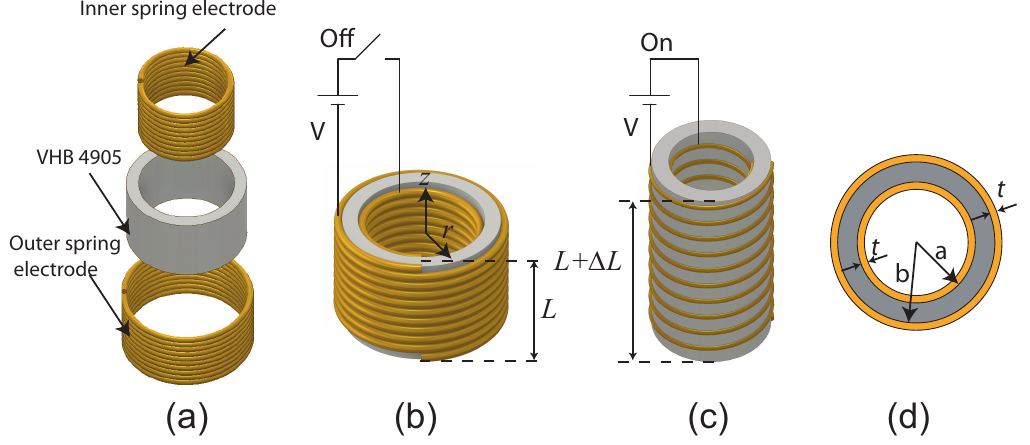
Figure 2. ( a ) Exploded view of proposed cylindrical Dielectric Elastomer Actuators (DEA) comprising VHB 4905 (3M Company, Maplewood, MN, USA) thin film folded into a hollow tube and sandwiched between two copper springs (inside and outside), which act as compliant electrodes; ( b ) without external electrical stimuli, device maintains its original shape; ( c ) under external electrical stimuli, device extends in the axial direction and decreases in the radial direction; ( d ) top view, where a is inner radius of VHB tube, b is outer radius of VHB tube, and t is wire diameter of springs ( L and ∆ L indicate original length before deformation and extended length of VHB